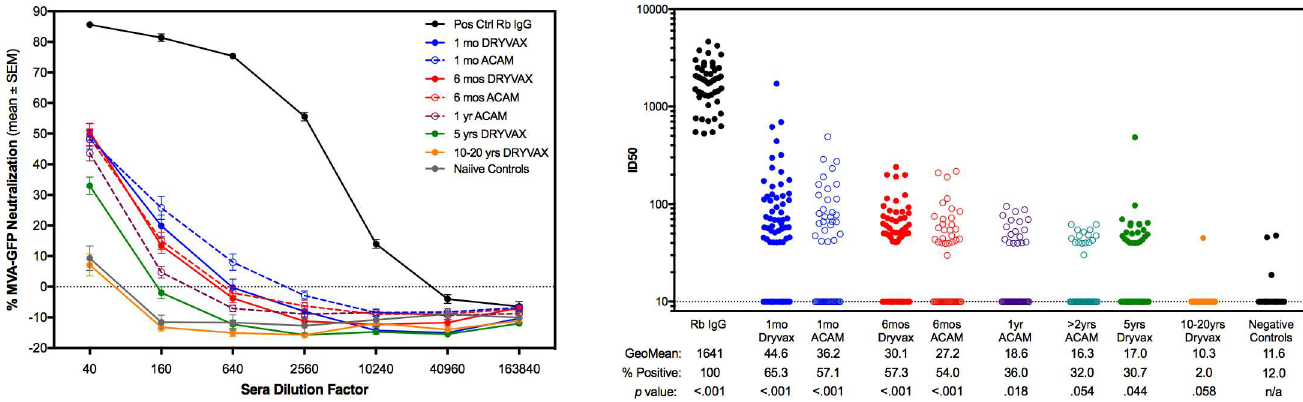
Fig 2. Neutralization of MVA-GFP infection of primary human dendritic cells. (A) Neutralization curves for each group are shown as the mean ± SEM of all serum samples at variousdilutions. (B) Curves were analyzedby non-linearregressionsigmoidaldose response curve fitting to determinethe ID50 of each sample. Geometric mean and percent positive are indicatedfor each group. The p value was generated by Mann-Whitney unpairedt-test of each group comparedto the negativecontrol (vaccinia-na ï